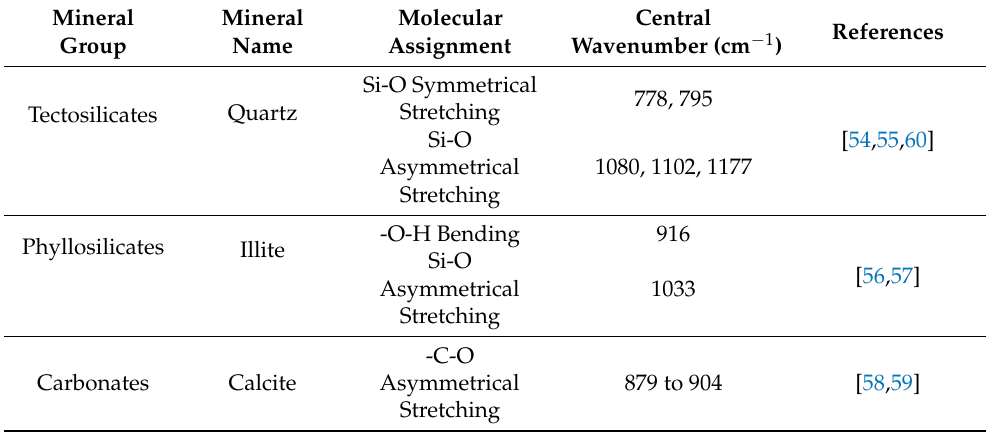
Table 1. Molecular assignments of some minerals in